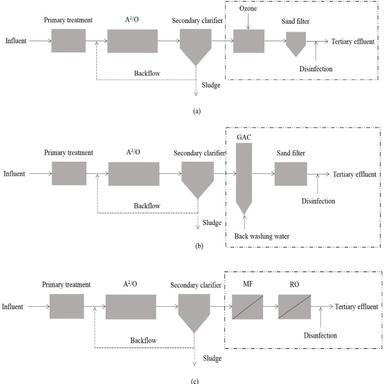
Schematization of the three advanced wastewater treatment processes. (a), (b), and (c) refer to scenario A, B, and C. The dashed box indicated the system boundary.